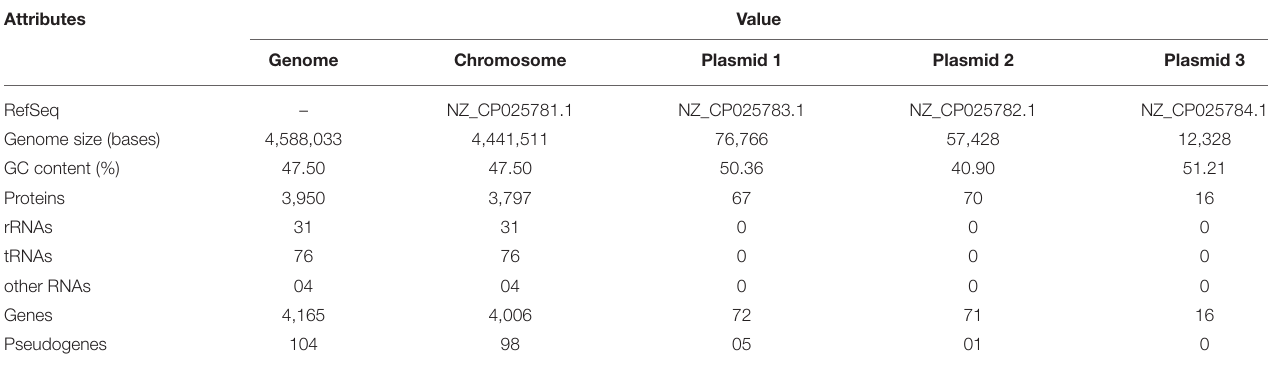
TABLE 1 | Genomic features of Iodobacter sp.